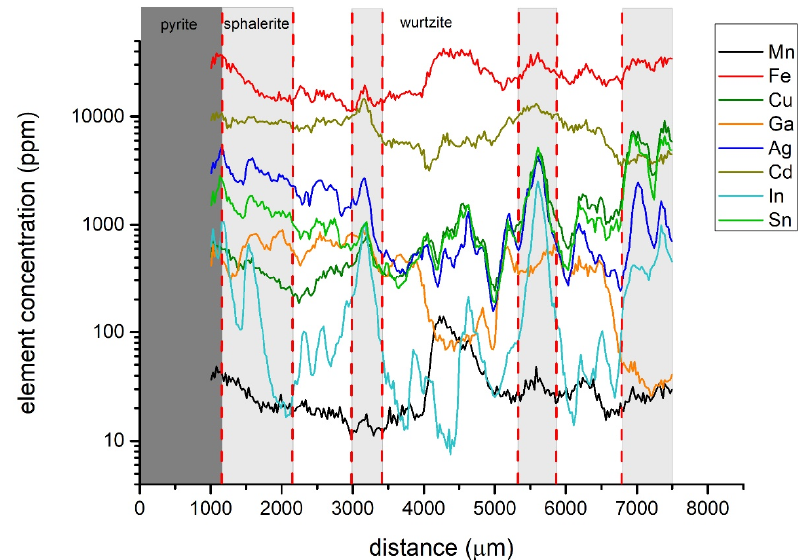
Figure 4. Laser ablation inductively coupled plasma mass spectrometry (LA-ICP-MS) concentration plot for selected minor and trace elements of the Animas sample. The position of the sphalerite bands are indicate by pale grey shading, the remaining are, other than the pyrite at the base, is wurtzite (assignment on the basis of mineral optics). Note the log scale for concentration.